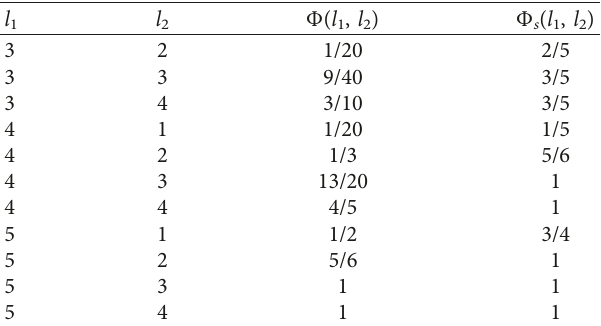
Table 8: Survival signature of the system under optimal swapping